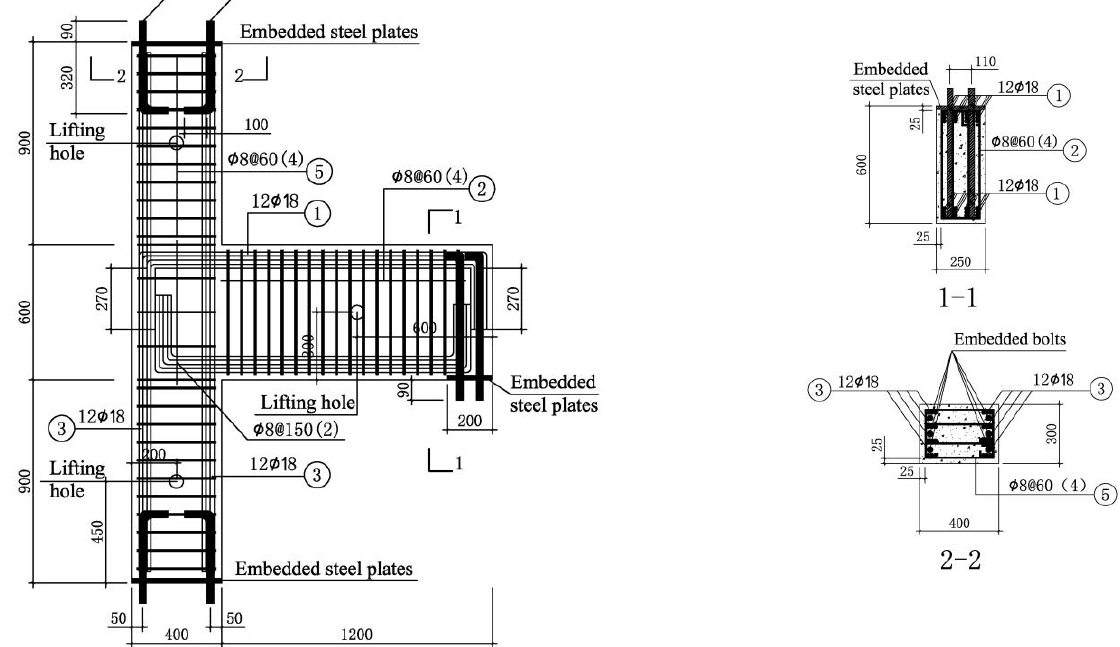
Figure 7. Dimensions and reinforcement of specimens BJ-1 and BJ-2 (Unit: mm). Table 4. Detailed reinforcement of specimens.